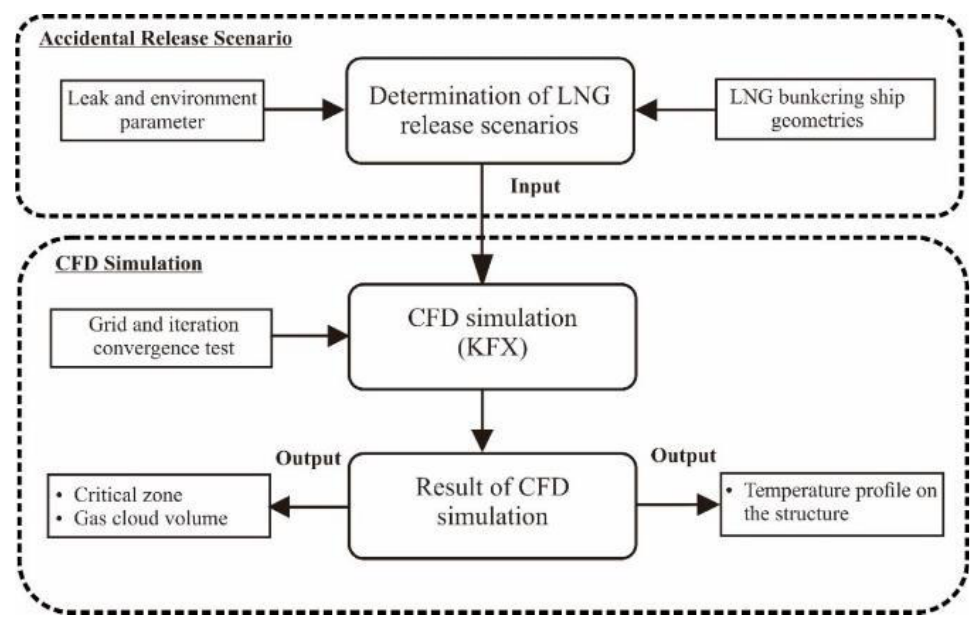
Figure 1. A framework for temperature reduction analysis.